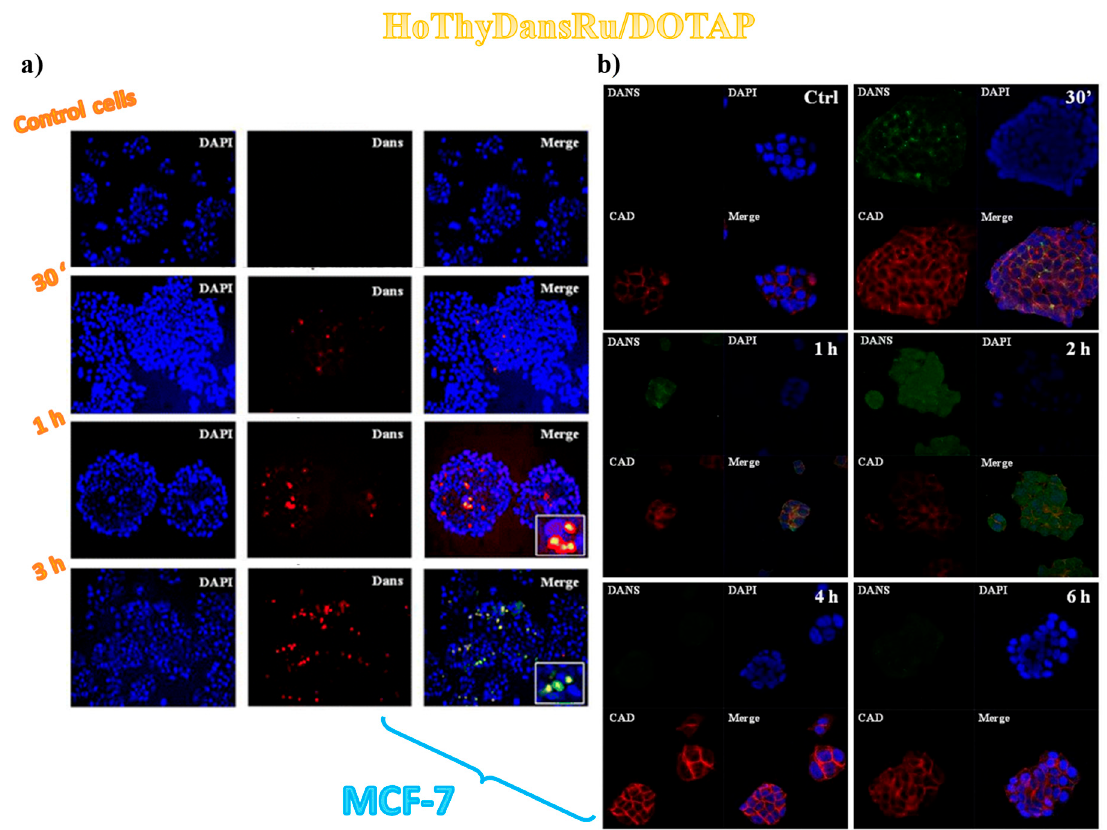
Figure 8. Human MCF-7 breast adenocarcinoma cells incubated with 100 µM HoThyDansRu/DOTAP liposome formulations and followed at different times: ( a ) fluorescent photomicrographs of cell monolayers showing the cellular localization of the fluorescent HoThyDansRu/DOTAP liposomes; ( b ) confocal microscopy bioimaging showing the cellular uptake of the fluorescent HoThyDansRu/DOTAP nanosystem. DAPI was used as a nuclear stain (shown in blue). Dansyl-dependent fluorescence (Dans) of HoThyDansRu/DOTAP liposomes is shown in red ( a ) or as green dots ( b ). E-cadherine-associated fluorescence (CAD), defining cell shape, is shown in red ( b ). In merged images (Merge), the two fluorescent emission patterns are overlapped. Insets in panel a represent higher magnifications of merged images showing cellular location of fluorescent dansylated ruthenium complexes. Figures were adapted with permission from [106] Copyright (2013) American Chemical Society ( a ) and from [100] ( b